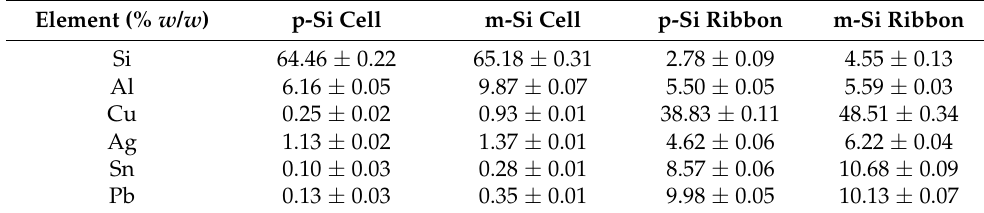
Table 2. Chemical composition of cells and ribbons.